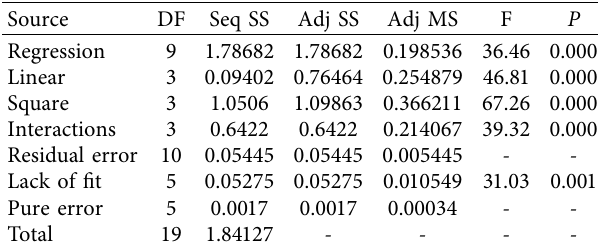
Table 11: Variance analysis of material removal rate